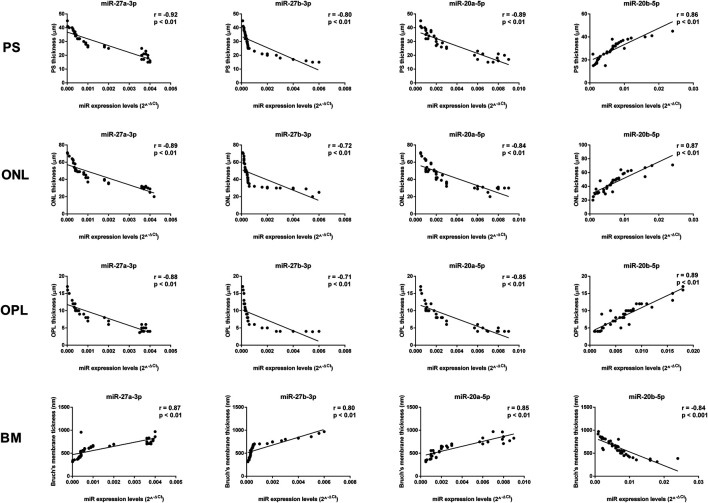
Significant correlation between age-related miRNA expression levels and retinal structure. miR-27a-3p, miR-27b-3p, and miR-20a-5p levels showed a negative correlation with PS, ONL, and OPL thickness, and they showed a positive correlation with Bruch’s membrane thickness. miR-20b-5p was positively correlated with PS, ONL, and OPL thickness, and it was negatively correlated with Bruch’s membrane thickness. Pearson correlation analysis was used to evaluate the strength of association between pairs of variable, by including all the samples with different age and gender. Differences were considered statistically significant for p values <0.05. PS, retinal photoreceptors layer; ONL, retinal outer nuclear layer; OPL, retinal outer plexiform layer; BM, Bruch’s membrane.